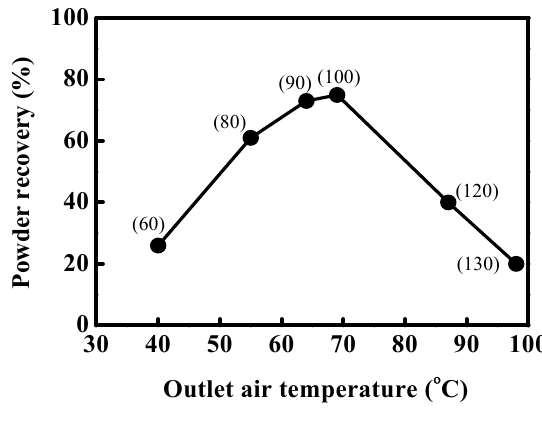
Figure 7. Effect of outlet air temperature on the powder recovery for formulation with equal-mass mixture of mannitol and